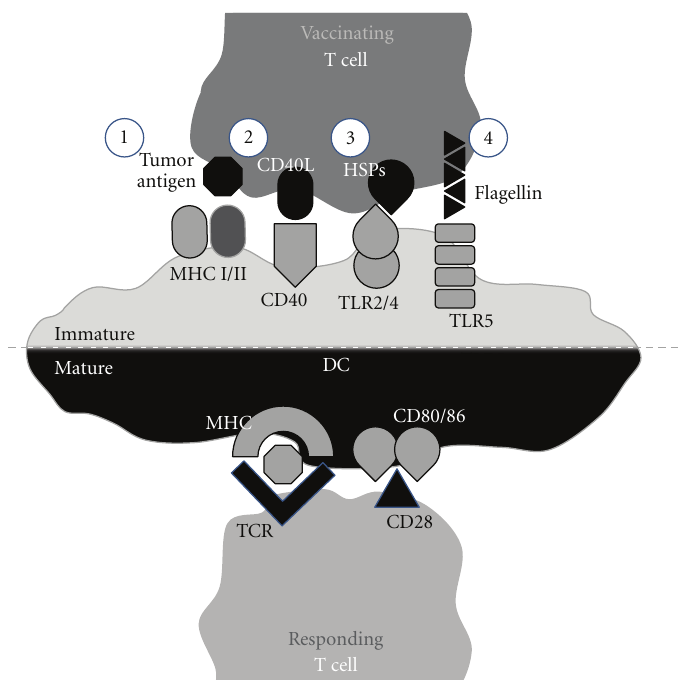
Figure 1: Targeting dendritic cells (DCs) in vivo using T cells for cancer vaccination. Upon infusion, T cells e ffi ciently home to lymphoid tissue where they encounter lymph node-resident DCs. T cells may be genetically modified to express tumor-associated antigens as well as molecules that can induce DC activation, such as CD40L, heat shock proteins (HSPs), and flagellin. Interacting DCs engulf and present antigen delivered by T cells on MHC class I and II molecules. T cell-mediated DC maturation results in the upregulation of costimulatory molecules, such as CD80 and CD86, which are necessary for the generation of potent helper CD4 + and e ff ector CD8 + T cell